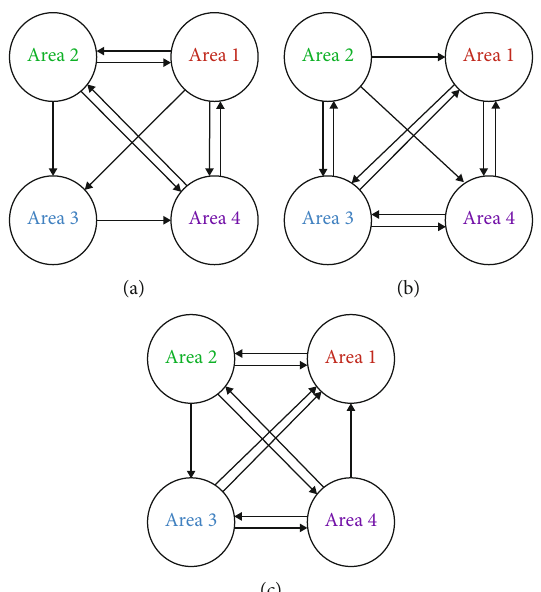
Figure 9: The causal connectivity of the features extracted by PCA under the three conditions: (a) the awake condition; (b) the fatigue condition; (c) the sleep deprivation condition. The connection between areas is signi fi cant ( P < 0 : 01